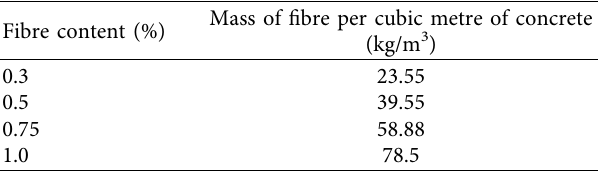
Table 4: Quantity of fibre per 1m 3 of